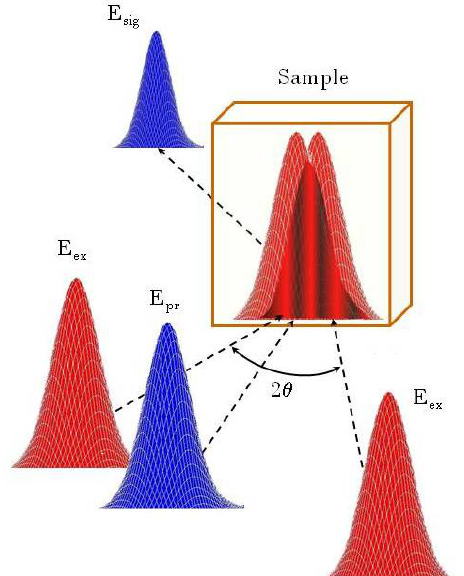
Figure 1. Schematic sketch of the Transient Grating (TG) experiment. E probe; E : signal; 2 θ : angle between pump sig